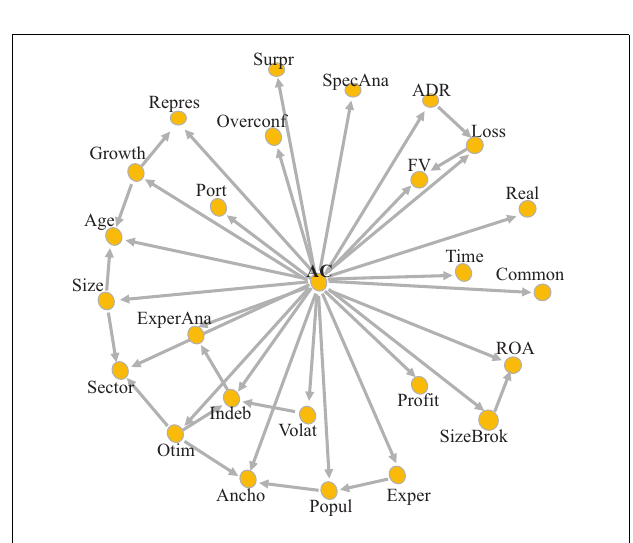
FIGURE 4 | List of variables in the k -dependence Bayesian ( k -DB) classification model, with a value of k = 5.